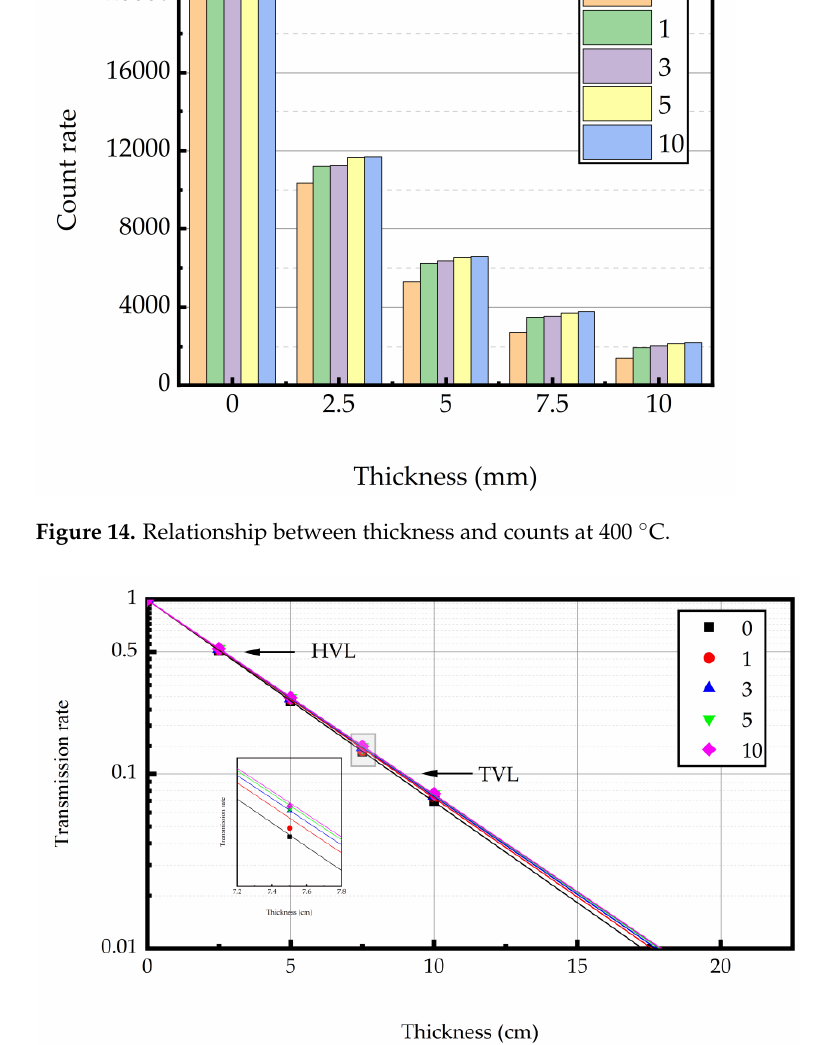
Figure 16. The relation between gamma-ray transmission rate and the concrete thickness at 300 °C.